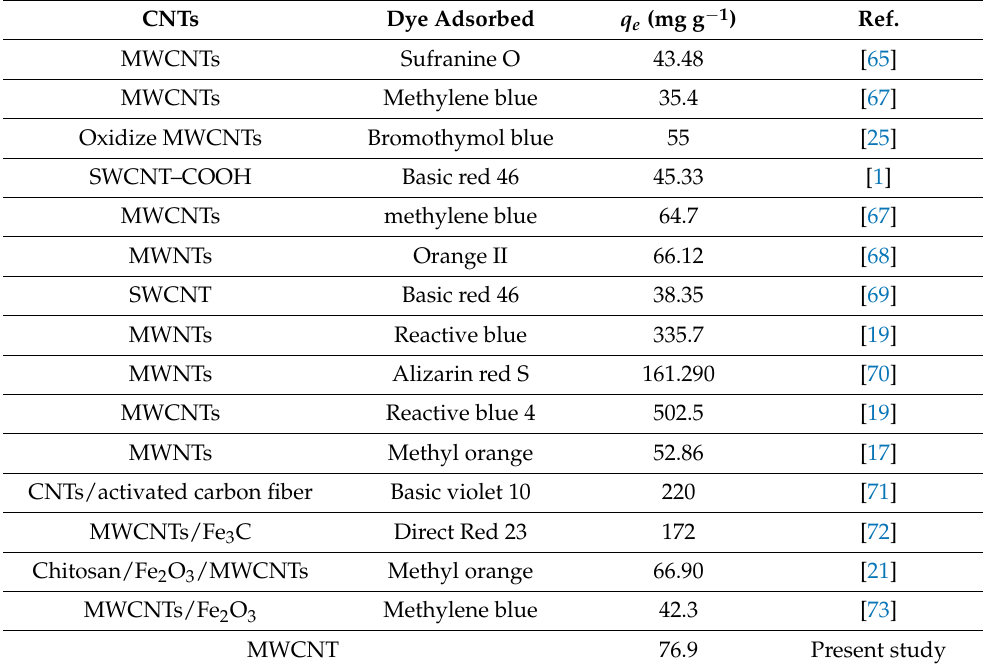
Table 7. Summary of the elimination of several dyes from aquatic mixtures by various carbon